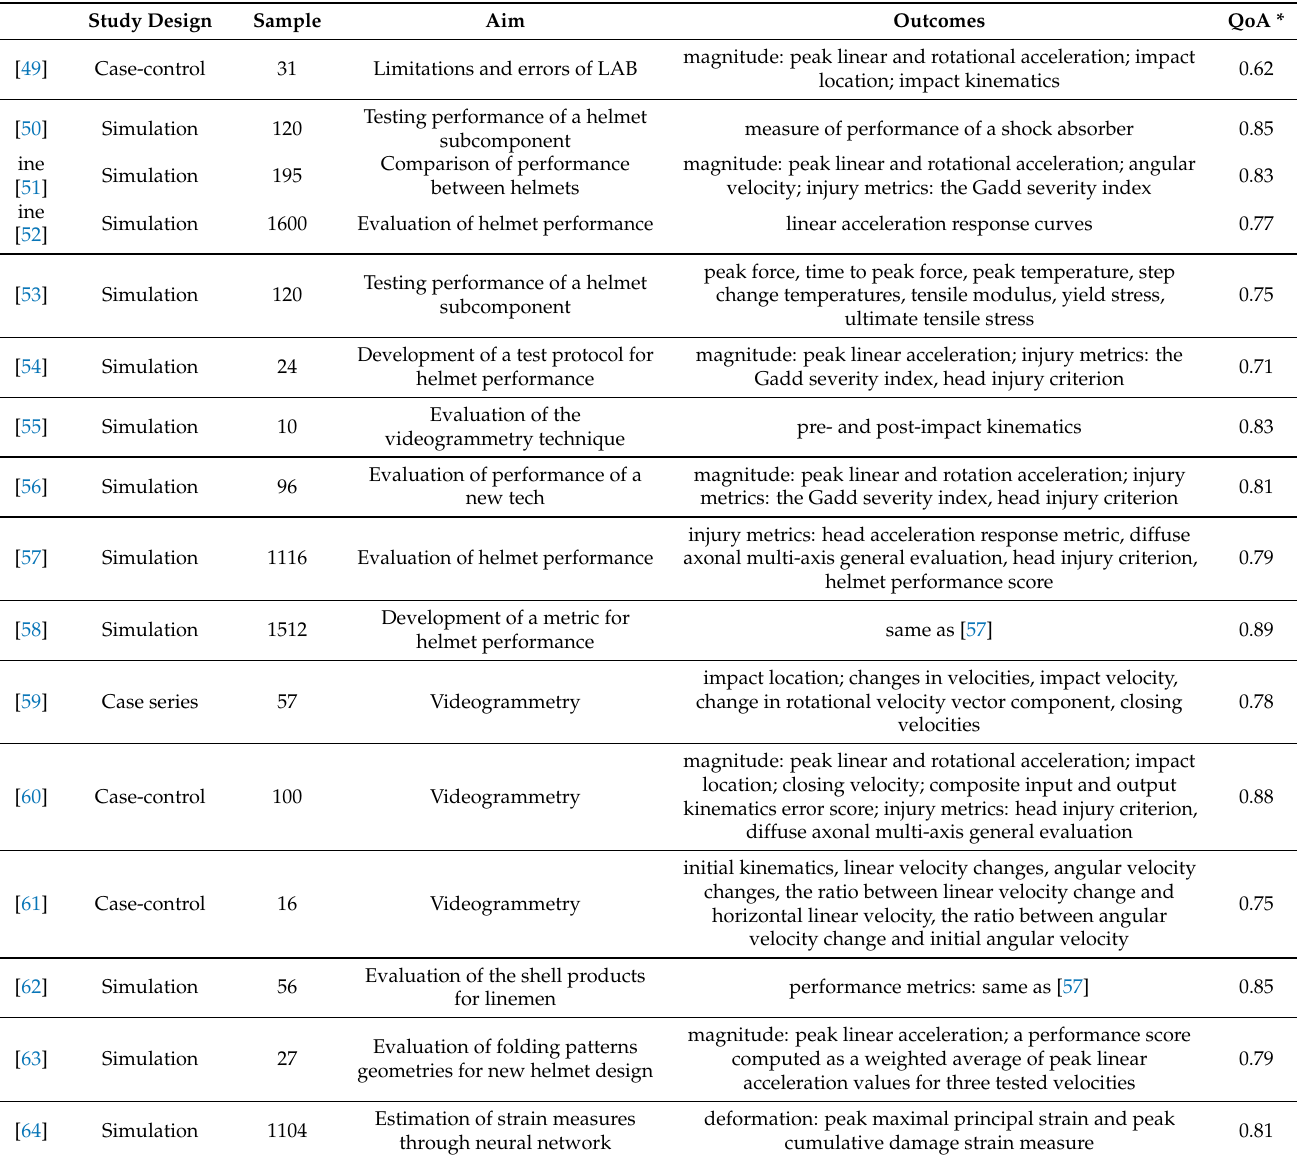
Table 1. Studies regarding the biomechanics of concussions studied by